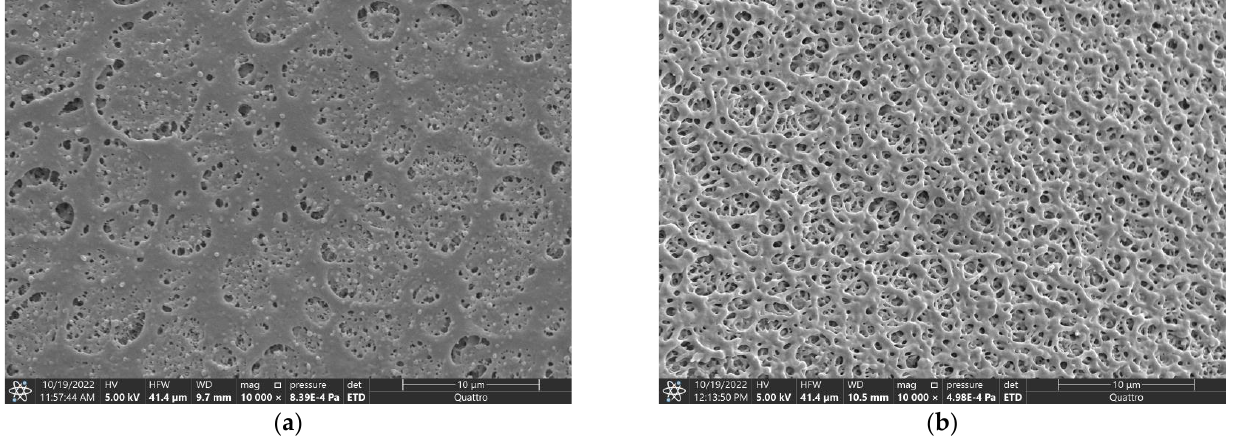
Figure 9. Surfaces of fibers formed from the 20 wt.% PLGA solution via immersion in ( a ) water and ( b ) water/TG (50:50) mixture.